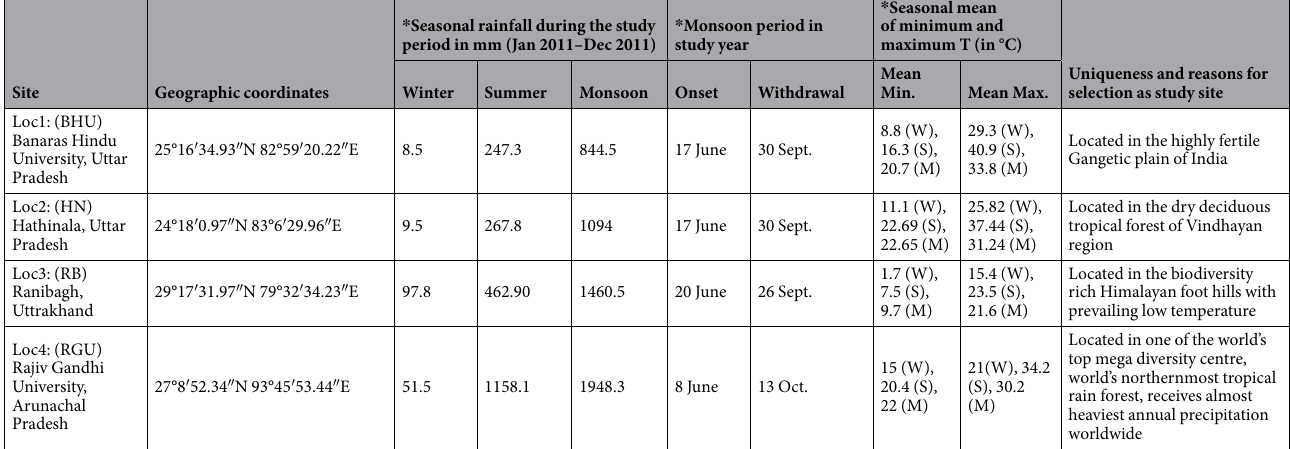
Table 5. Geographic coordinates, climatic conditions and unique characteristics of study sites. ( *